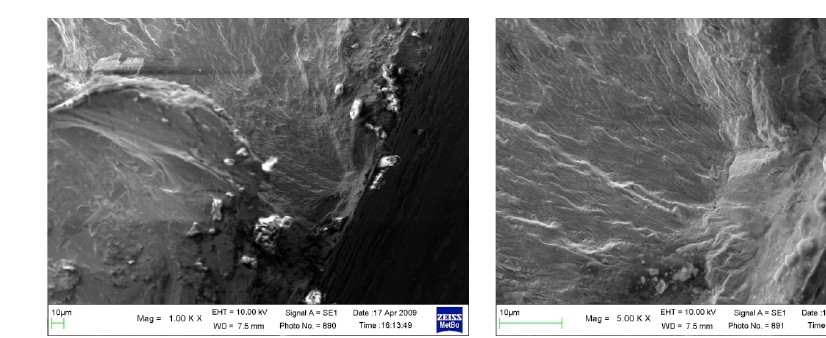
Fig. 7a: Fatigue crack origin in specimens with a blunt notch Fig. 8a : Fatigue crack origin in specimens with a sharp notch